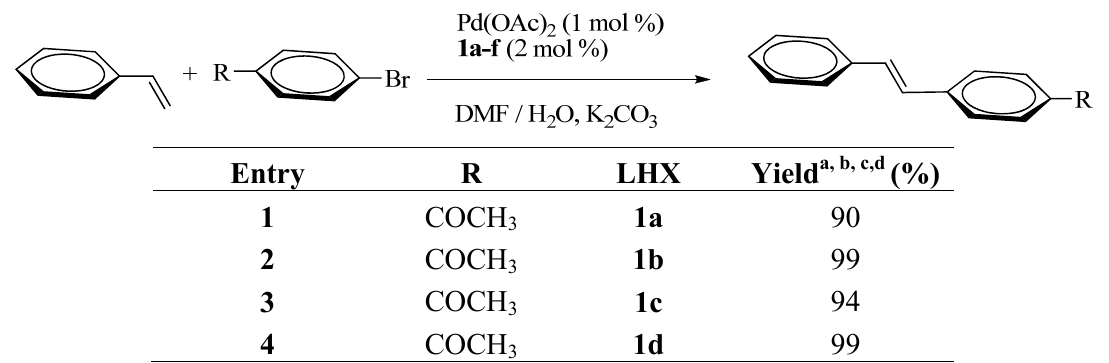
Table 1. The Heck coupling reaction of aryl bromides with